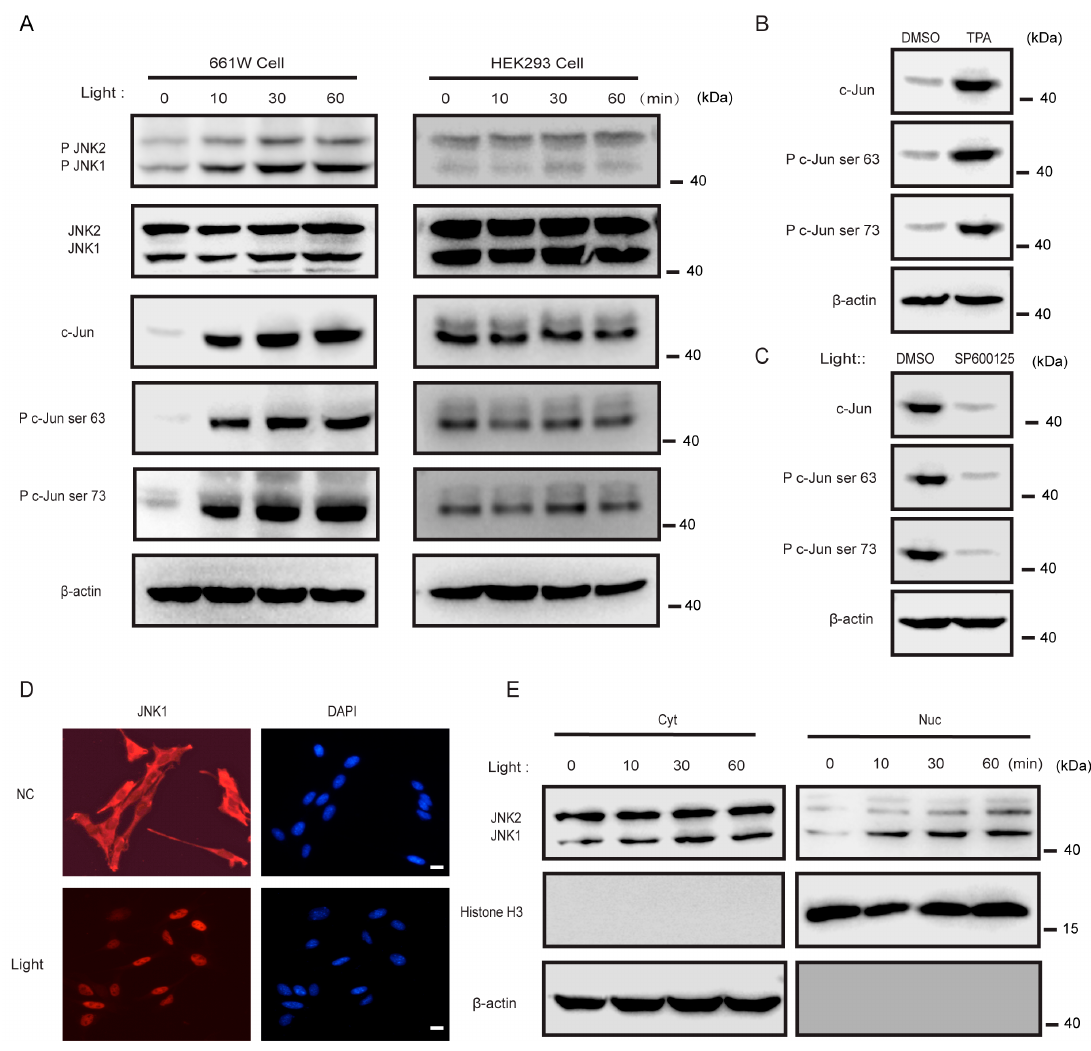
Figure 4. Light activated JNK1, not JNK2, in 661w cells: ( A ) 661W cells and HEK293 cells were treated by light for the indicated times. Cell lysates were collected for western blot analysis of p-JNK, JNK, c-Jun, p-c-Jun (ser63), p-c-Jun (ser73), and β -actin. ( B ) Here, 661W cells were treated with DMSO (dimethyl sulfoxide) and 100 ng/mL phorbol 12-myristate 13-acetate (TPA) for 30 min. Cell lysates were collected for western blot analysis of c-Jun, p-c-Jun (ser63), p-c-Jun (ser73), and β -actin. ( C ) Here, 661W cells were treated with DMSO and 20 μ mol/mL SP600125 for 2 h and then treated by light for 30 min. Cell lysates were collected for western blot analysis of c-Jun, p-c-Jun (ser63), p-c-Jun (ser73), and β -actin. ( D ) Here, 661W cells were treated by light for 30 min and then stained with DAPI (the DNA-binding dye), an antibody specific for JNK1, and imaged by immunofluorescence microscopy. Scale bars: 10 µ m. ( E ) Here, 661W cells were treated by light for 30 min. Nuclear (Nuc) and cytoplasmic (Cyt) fractions were separated and then collected for western blot analysis of